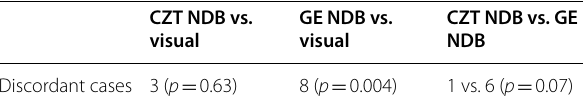
Table 4 Comparison of CZT NDB and GE NDB z-scores along with visual rating for the putamen in the test group ( n 48); p = values were calculated by using McNemar’s test CZT NDB vs. GE NDB vs. visual